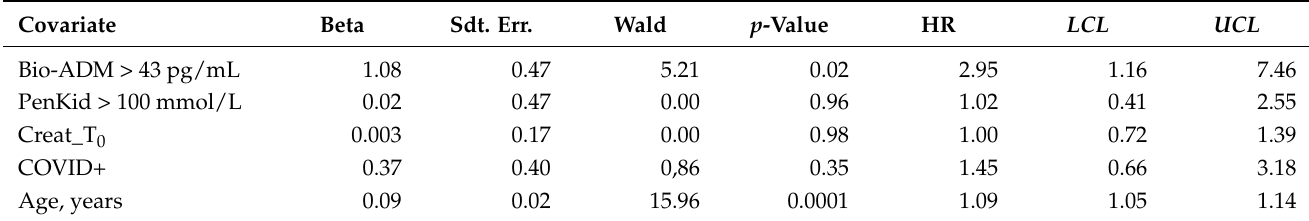
Table 2. Cox analysis for Bio-ADM, penKid, creatinine, COVID-19 positivity, and age.